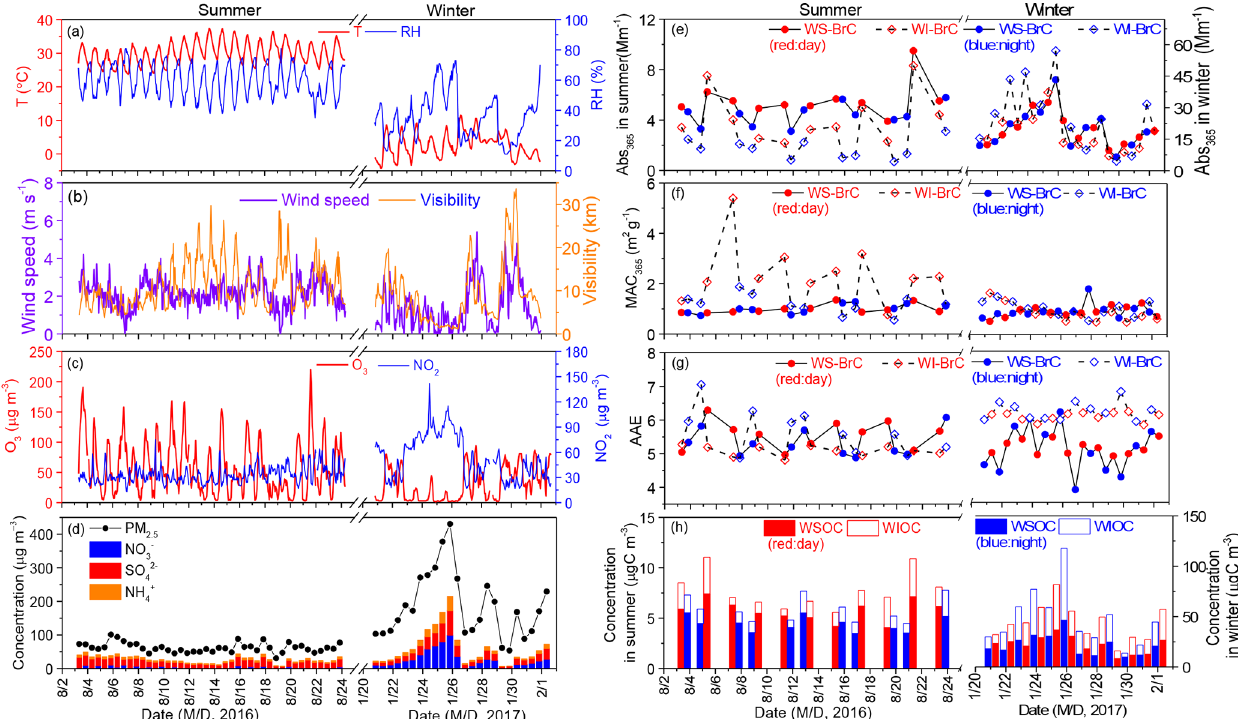
Figure 1. Temporal variation in meteorological parameters (a, b) and concentrations of major chemical compositions, Abs 365 , MAC 365 and AAE of water-soluble and water-insoluble BrC in PM 2 . 5 from the rural area of northwest